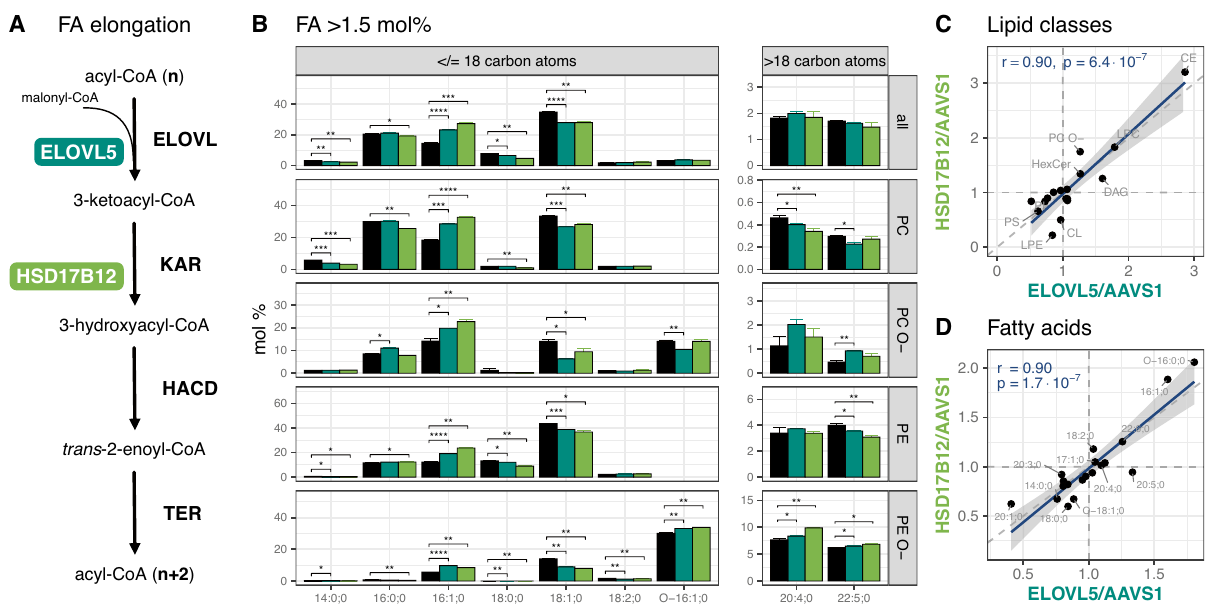
Figure 7. HSD17B12 and ELOVL5 knockouts compared to AAVS1 control (black). ( A ) The long-chain fatty acid elongation cycle consists of 4 enzymatic steps that in sequence extend the fatty acid (n) by two carbon atoms (n + 2). (1) Elongation of very-long-chain fatty acids (ELOVL 1–7); (2) 3-ketoacyl-CoA reductase (KAR); (3) 3-hydroxyacyl-CoA dehydratase (HADC); (4) trans-2,3-enoyl-CoA reductase (TER). ( B ) Fatty acid profiles: greater than 1.5 mol% across CE, DAG, LPC, LPE, LPE O-, PC, PC O-, PE, PE O-, PG, PI, PS lipid classes and individual profiles of PC, PC O-, PE, PE O-. Fill colors of ELOVL5 and HSD17B12 are indicated in ( A ). The AAVS1 control is shown in black. Means are indicated by bar plots. Error bars correspond to standard deviations (n = 3). p-values have been adjusted for the total number of fatty acids (n = 47) or the total number of fatty residues and lipid classes (n = 199) within each gene knockout and are represented by stars. Only lipid species were used, which appeared at least 2 × in each of the 3 cell lines (n = 517). ( C ) Correlation of lipid class ratios: of ELOVL5/AAVS1 and HSD17B12/AAVS1. The Pearson’s correlation coefficient (r) and its p-value are shown in the upper left corner. ( D ) Correlation of total FA ratios: same as ( D ) for total fatty acid